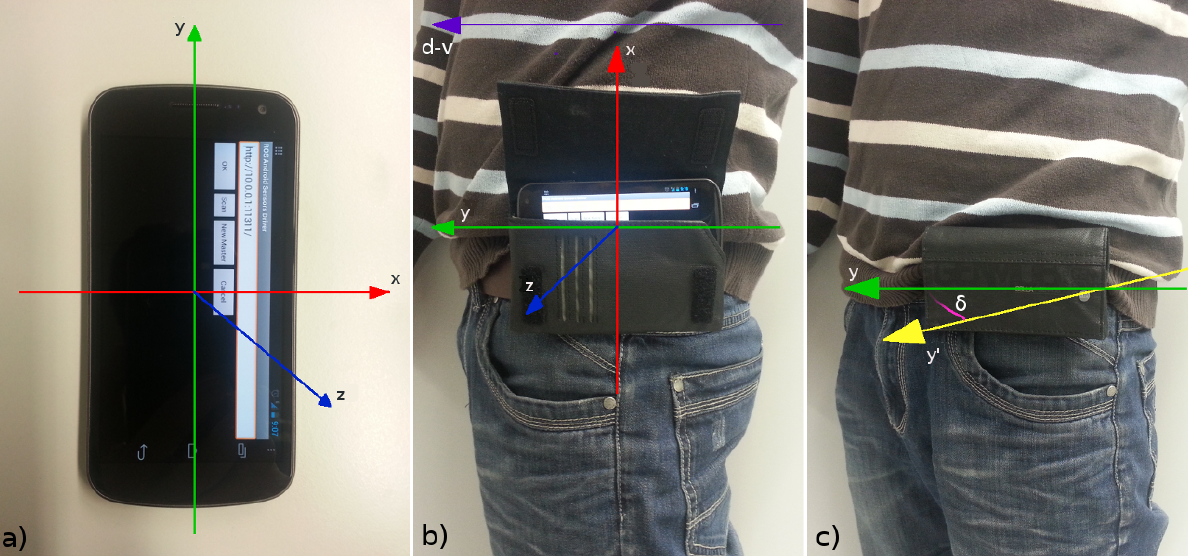
Figure 4. Frame definitions. a) Smartphone reference axes. b) Smartphone in the correct predetermined orientation at the expected position and orientation on the waist. c) Smartphone in the non-expected position and orientation on the waist. There is an angle of error in the transverse body plane between the device's real (green arrow) and expected (yellow arrow)